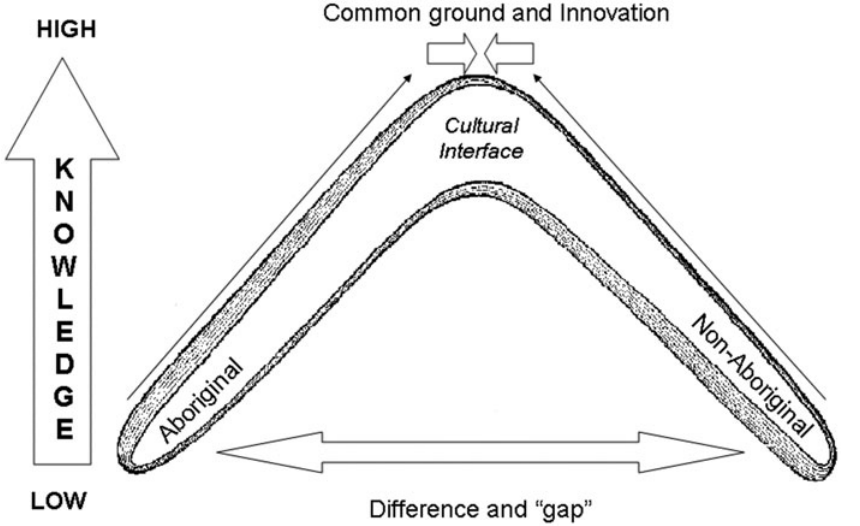
Fig. 1. Boomerang matrix of cultural interface knowl- edge. Yunkaporta (2009, p.